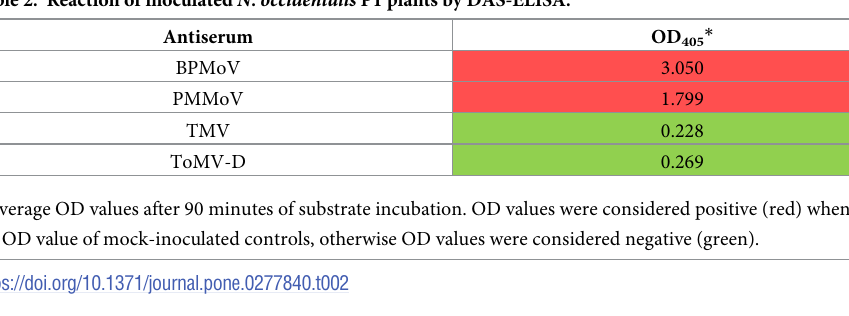
Table 2. Reaction of inoculated N . occidentalis P1 plants by